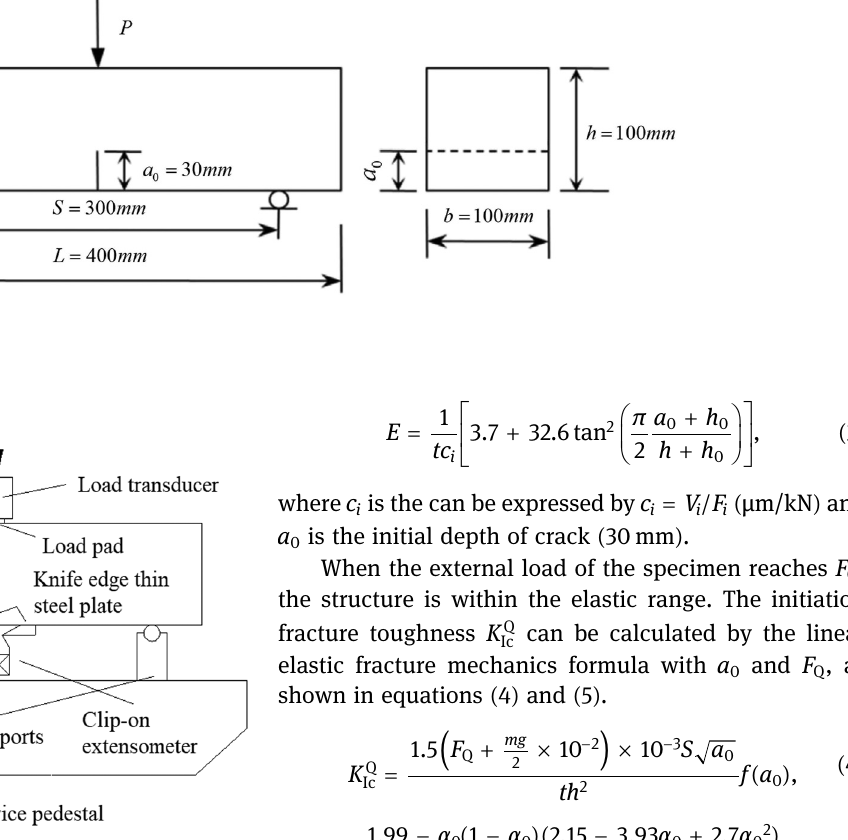
Figure 5: Loading diagram.